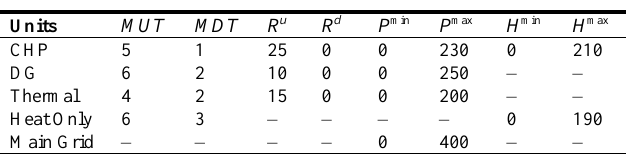
TABLE III T ECHNICAL DATA OF UNITS AND THE MAIN GRID